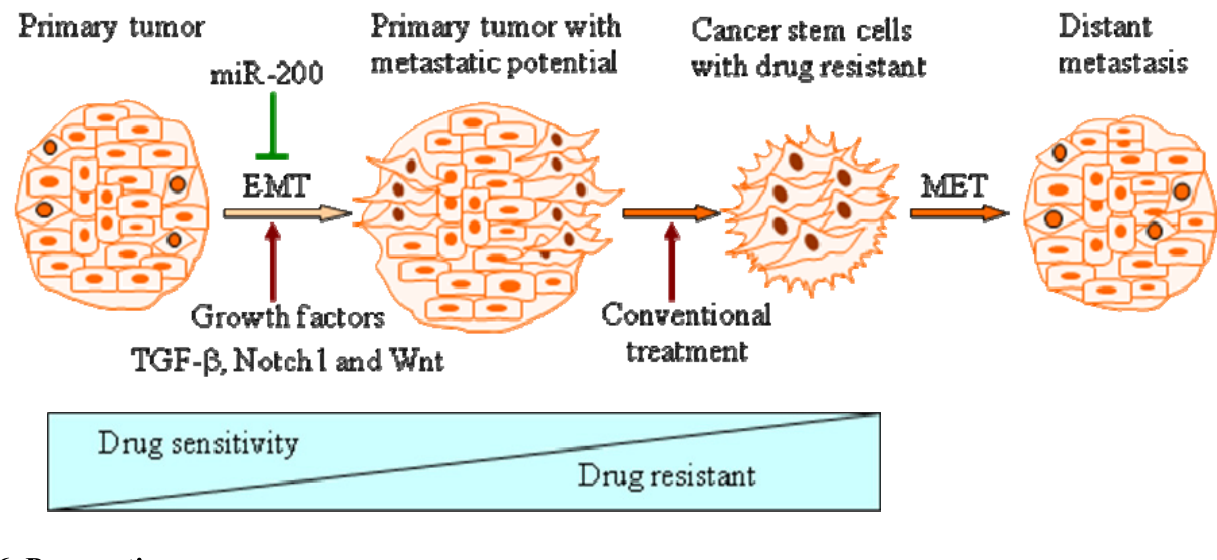
Figure 1. Induction of epithelial-to-mesenchymal transition (EMT)-phenotypic cells produces cancer stem-like cells with drug-resistant characteristics. Growth factors, including FGF, EGF, PDGF-B and PDGF-D as well as factors such as TGF-  , Notch-1 and Wnt, can induce EMT, while miR-200 family inhibits EMT by regulating the expression of transcription repressors ZEB1 and ZEB2. EMT-phenotypic cells acquire stem-like cell signatures characterized by increased metastatic capacity, self-renewal ability and acquired drug resistance. These cells metastasize to distant sites and undergo MET to produce metastatic tumors that are phenotypically similar to the primary